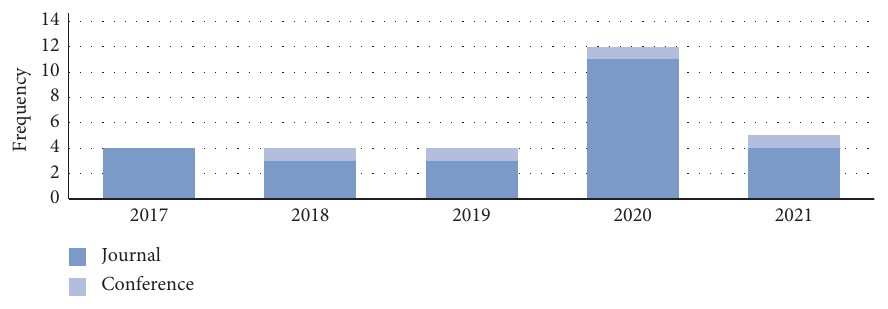
Figure 3: Te number of articles published annually from 2017 to 2021 by